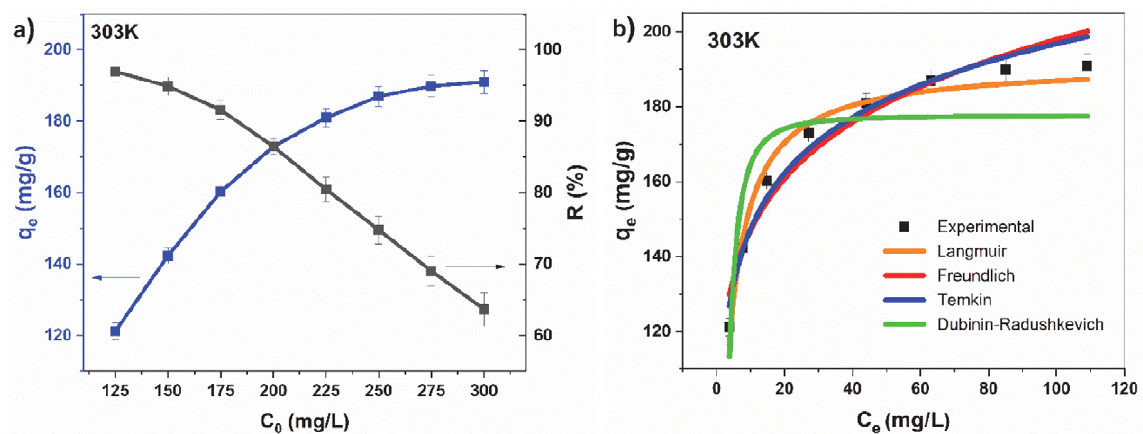
Fig. 8. (a) Effect of initial MB concentration on MB removal efficiency and adsorption capacity by SA-RPB at 303 K; (b) MB adsorption isotherm by SA-RPB based on Langmuir, Freundlich, Temkin, and Dubinin–Radushkevich isotherm models at 303 K. The experiments were conducted using 1.0 g/L SA-RPB at different initial MB concentrations and 6.5 pH